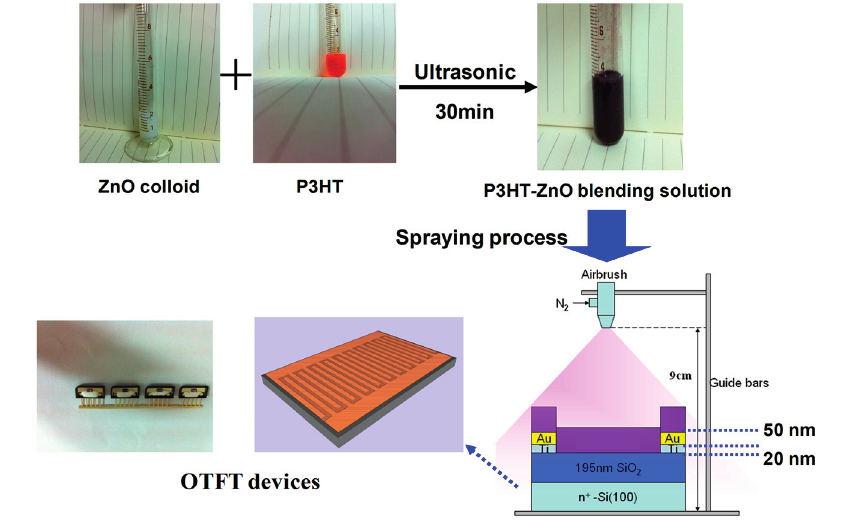
Figure 1. A schematic drawing of spraying process and organic thin-film transistor (OTFT) devices.